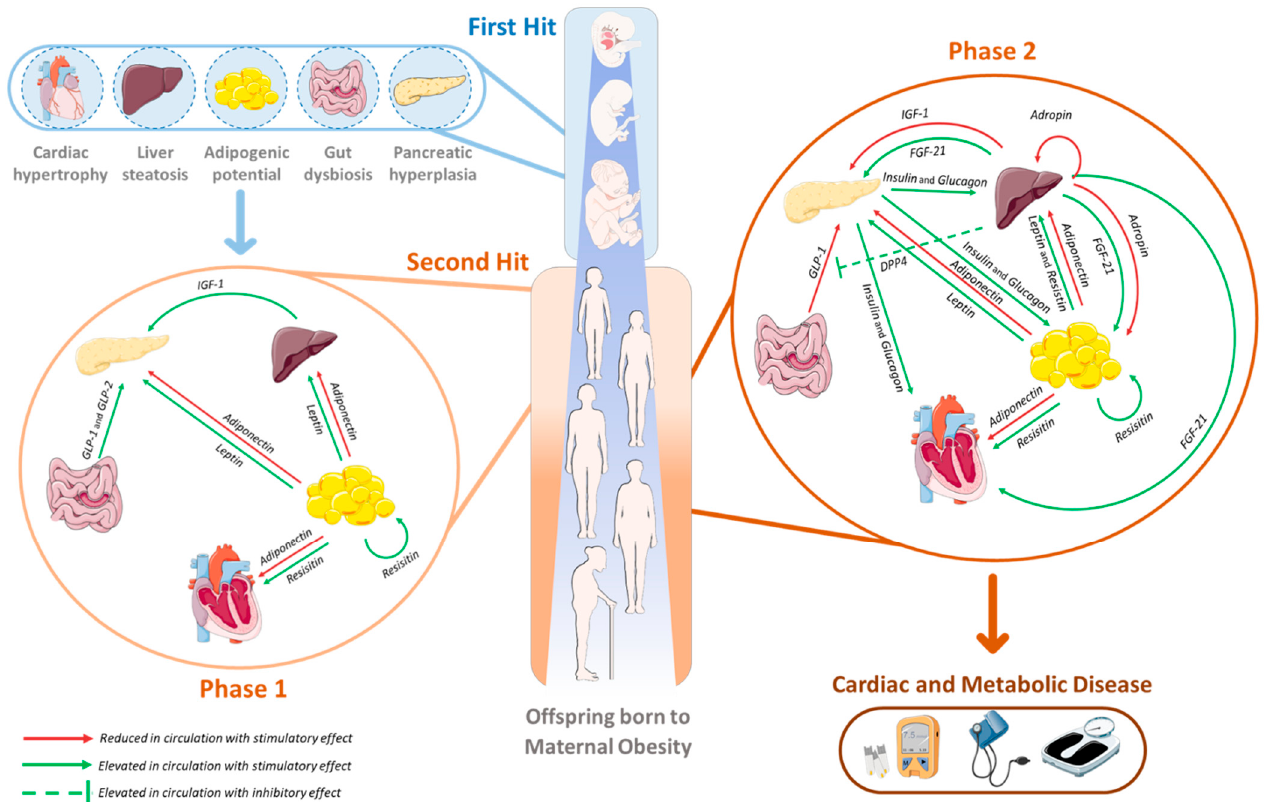
Figure 2. Endocrine-metabolic axis programming in offspring born to maternal obesity. The modu- lation of the organs’ maturation and differentiation state by Maternal Obesity (MO) throughout the developmental phase results in early dysregulation of multiple organs, including adipose tissue, gut, liver, pancreas, and heart—the first hit of developmental programming. Subsequently, in the first phase of the second hit, adipose tissue dysfunction and gut dysbiosis result in the different secretion of multiple hormones (e.g., adiponectin, leptin, glucagon-like peptide (GLP) 1/2), which impact and regulate other tissues’ (e.g., liver, heart, pancreas) metabolism. The liver and pancreas alter their metabolic function as a response to the endocrine signaling resultant from adipose tissue and gut dysregulation, which induces organ-specific metabolic dysfunction. In the second phase, the pancreas and liver also modulate the release of pancreatic and hepatic endocrine molecules, which leads to a new endocrine physiological state and impacts other tissues including the heart— the second hit of developmental programming. The endocrine–metabolic axis programming pro- motes systemic metabolic adaptations, which increases organ-specific and systemic disease predis- position. Red arrows represent endocrine molecules whose circulating levels are decreased in MO, and green arrows are endocrine molecules with greater circulating concentrations in MO. Dashed lines are set for hormones capable of inhibiting other hormones’ endocrine effects.